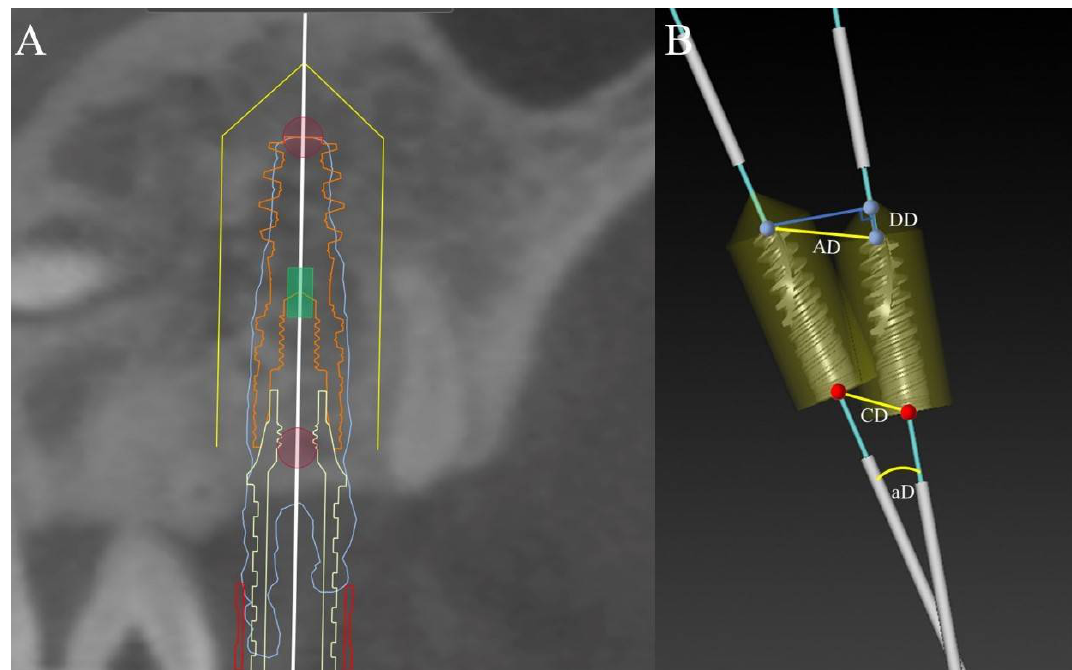
Figure 4. Accuracy measurement: ( A ) Registration according to the contour of the real implant position with a new implant; ( B ) The measurement of coronal deviation (CD), apical deviation (AD), depth deviation (DD) and angular deviation (aD).